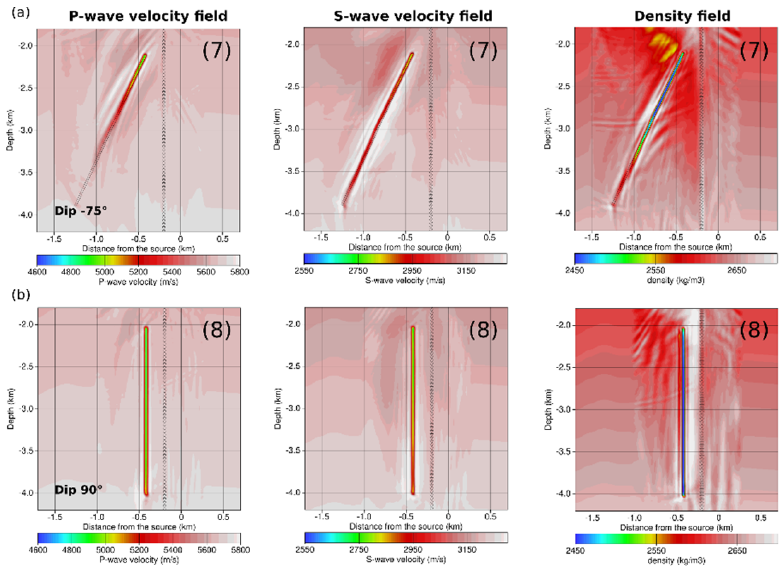
Figure 10. The retrieved P-wave velocity field, S-wave velocity field and density field for faults ( a ) 7 and ( b ) 8 (Figure 7). The fault 7 is 200 m far to the closest receivers in its upper part. We show only the interest area showed by the white rectangle in Figure 2c. Even for a vertical fault, the FWI shows a high potential to accurately recover its shape and the physical contrasts. In this case, the fault is accurately delineated, and the P-wave velocity and the density fields are recovered with a high precision. The S-wave velocity model show a correct delineation, but the contrasts are not well estimated in the deeper part of the fault, which could be explained by a low P-to-S reflected or less transmitted converted S-waves.